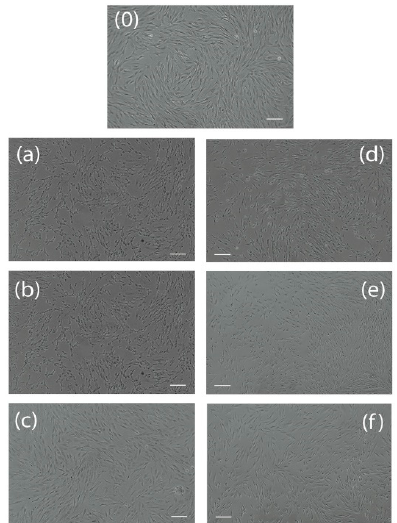
Table 3. Average cytotoxic evaluations of the mixtures using the Sulphordamine B (SRB) method. Viability Membranes Media